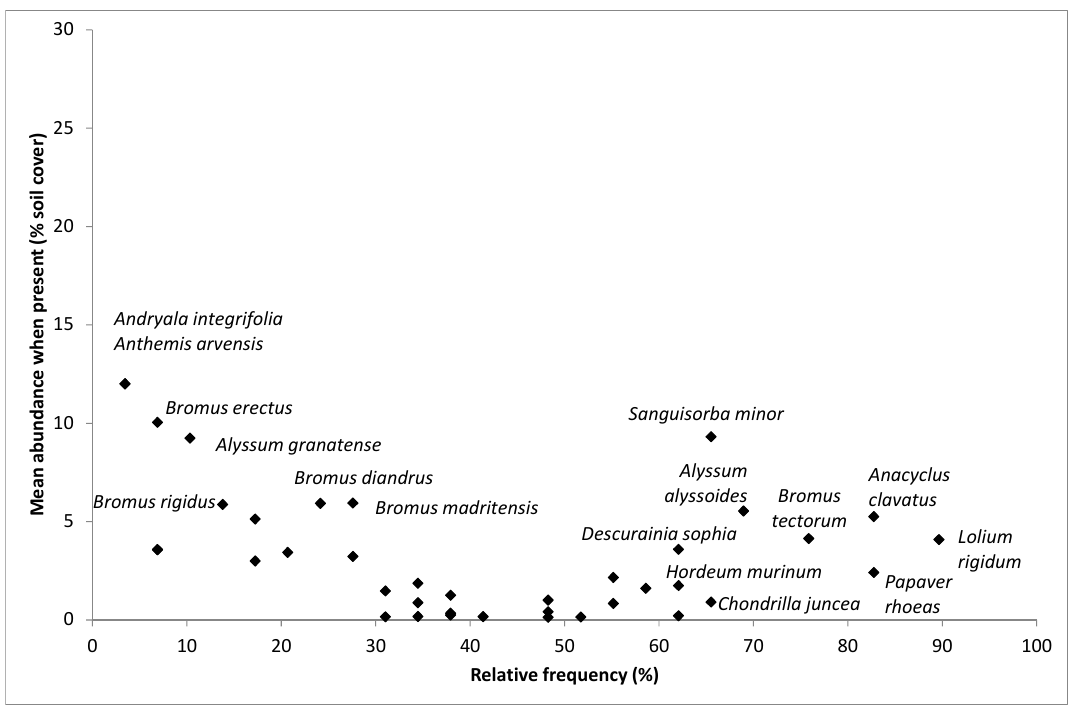
Figure 7. Species relative frequency and mean abundance when present in sainfoin fields in their third year of establishment (S3). Data of years 2011–2014 pooled together.